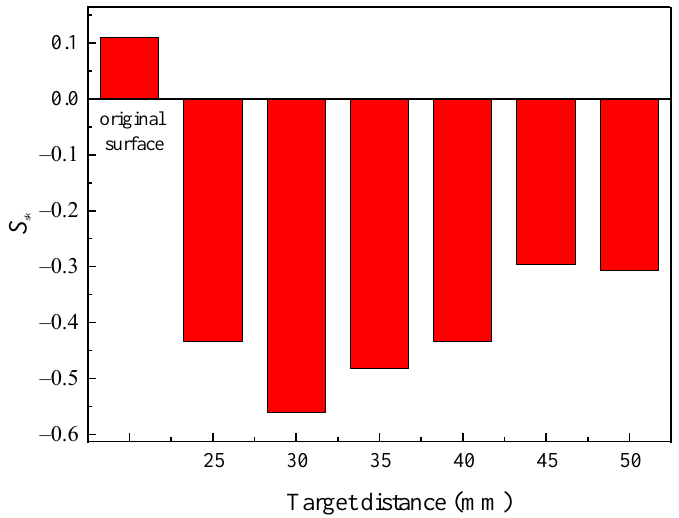
Figure 13. Variation in skewness with target distance.